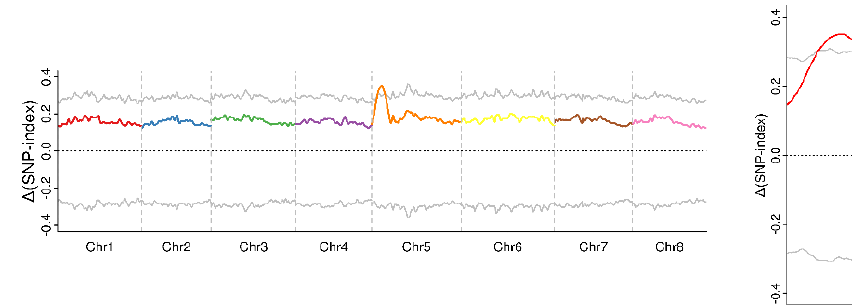
Table 3. Summary of sequencing data of